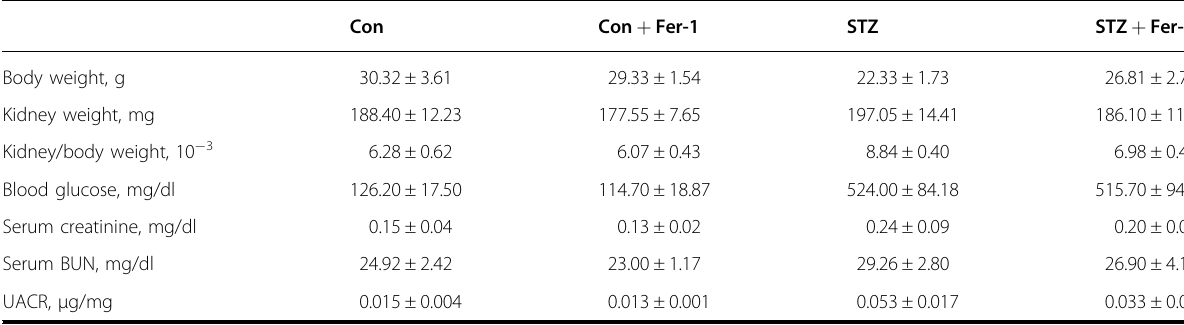
Table 2 Kidney function parameters in animal